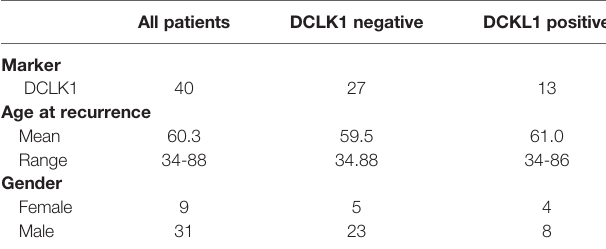
TABLE 2 | Demographic and clinical characteristics of patients with recurrent HNSCC. All